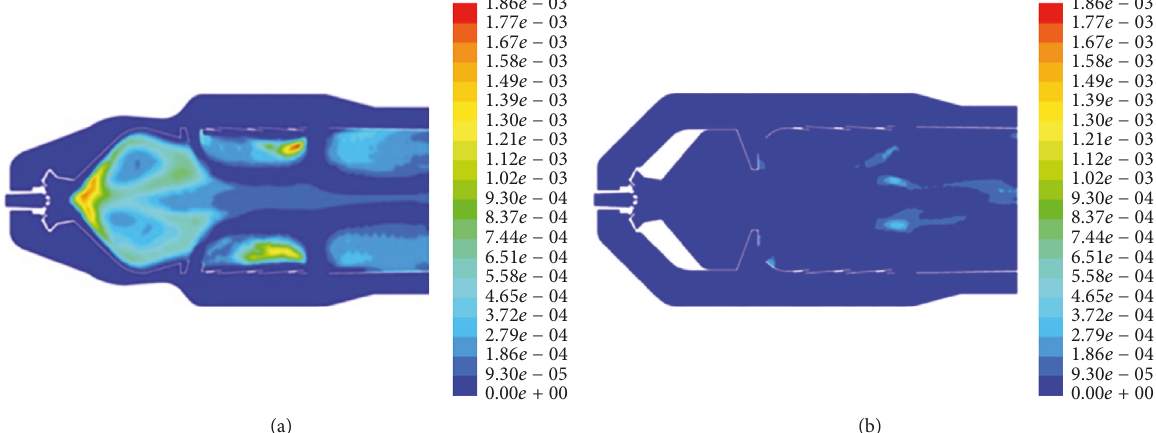
Figure 17: Distribution of NO mass fractions in the longitudinal sections of the combustor: (a) modified design 1; (b) modified design 2.